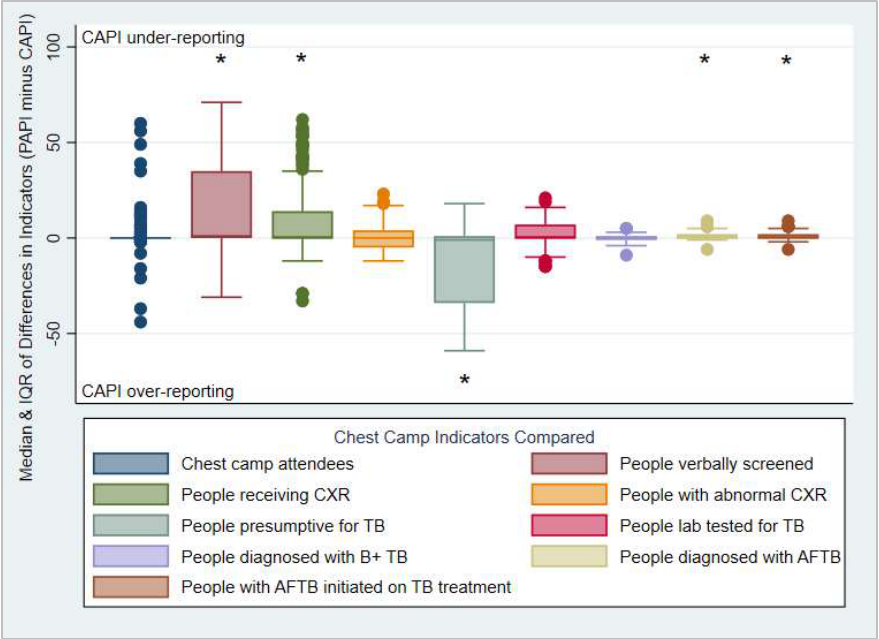
Figure 3. Median and interquartile ranges of mean differences between PAPI and CAPI chest camp indicators. * Significant difference ( p < 0.05) in mean values reported between PAPI and CAPI.